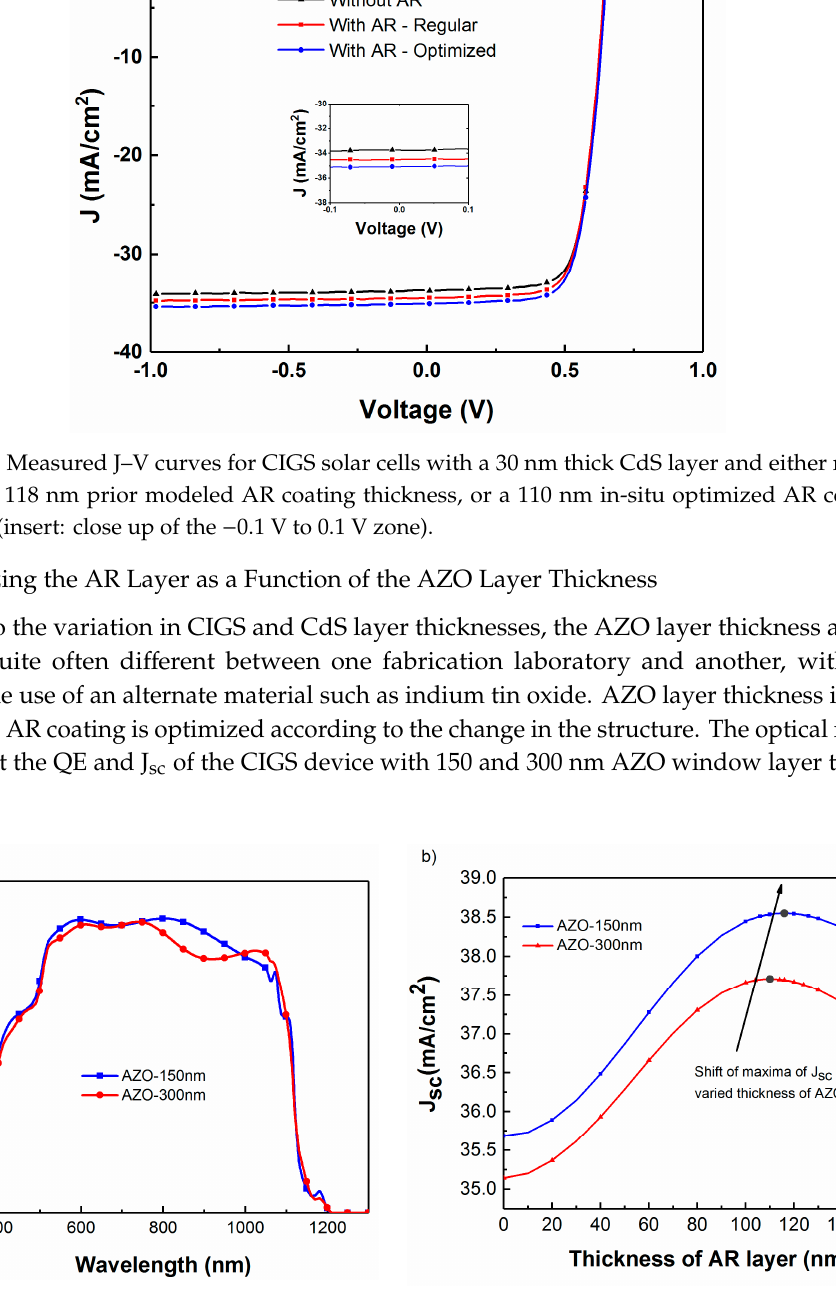
Figure 11. Real-time reflectance for CIGS devices with different layers of CdS thickness.